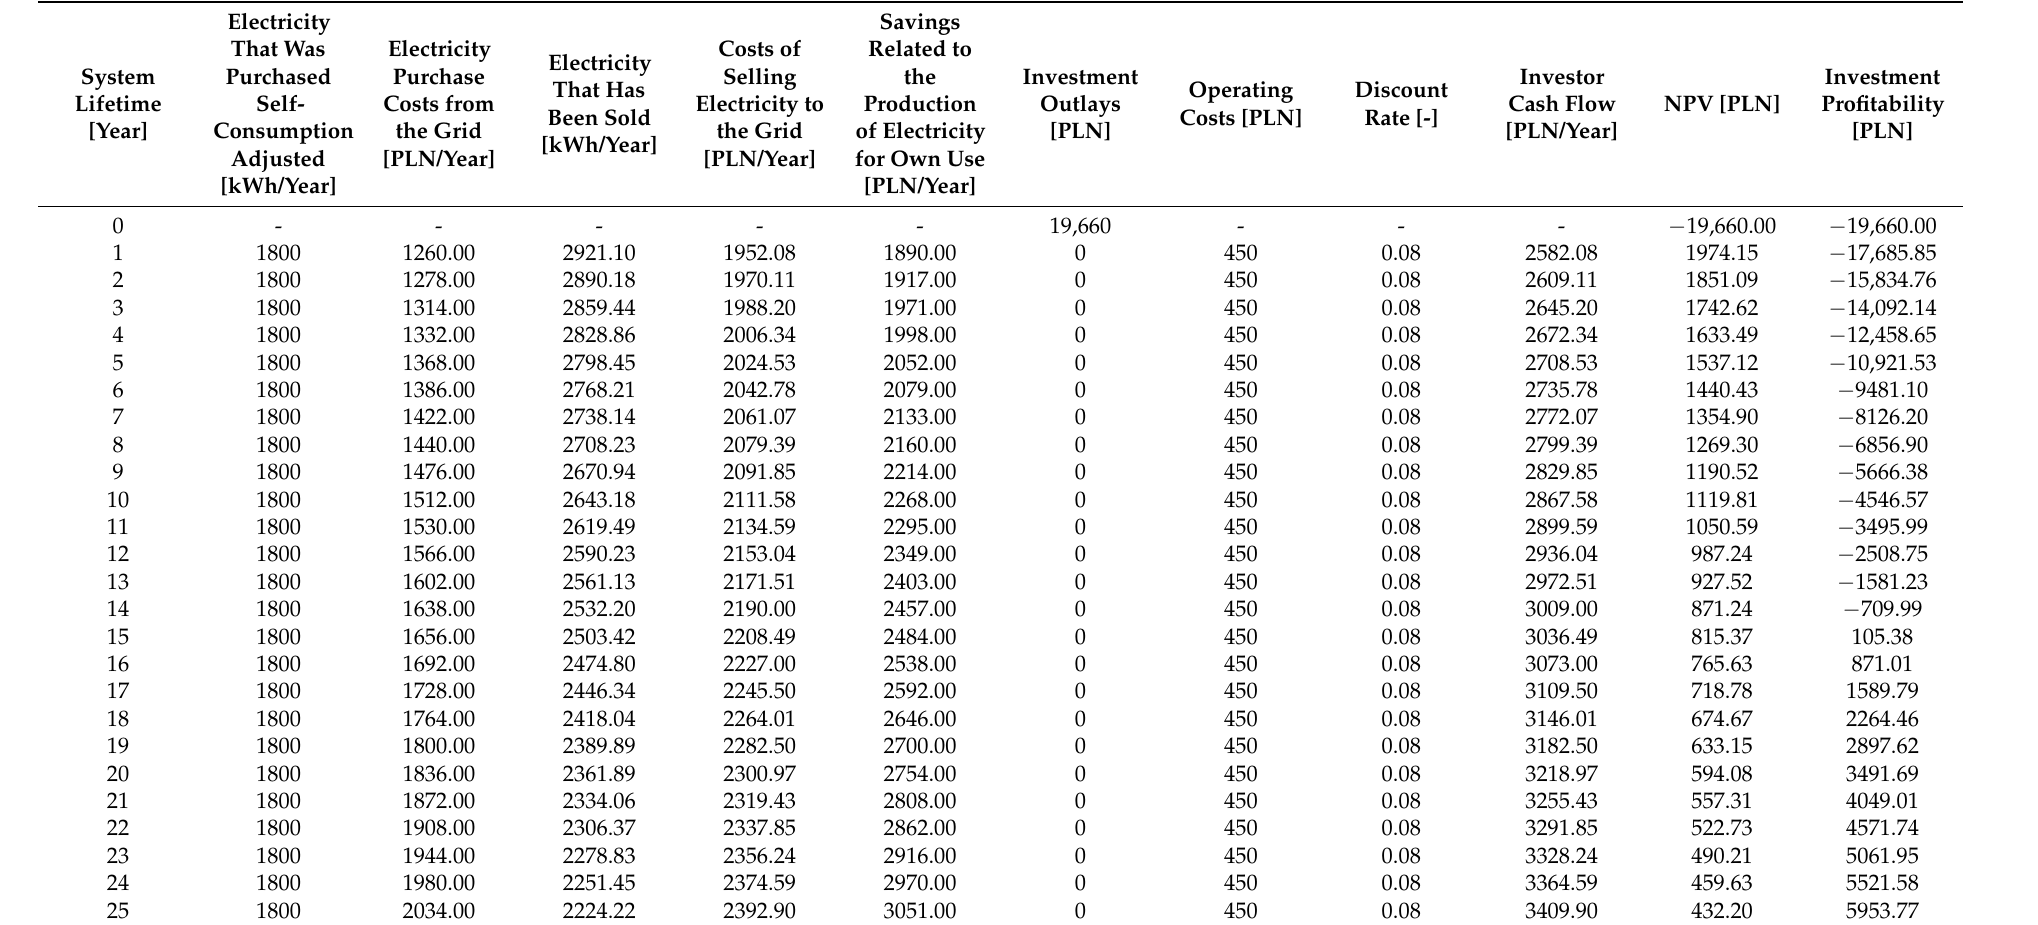
Table A10. NPV results of the PV installation for the net-billing system based on hourly prices, at a 60% self-consumption